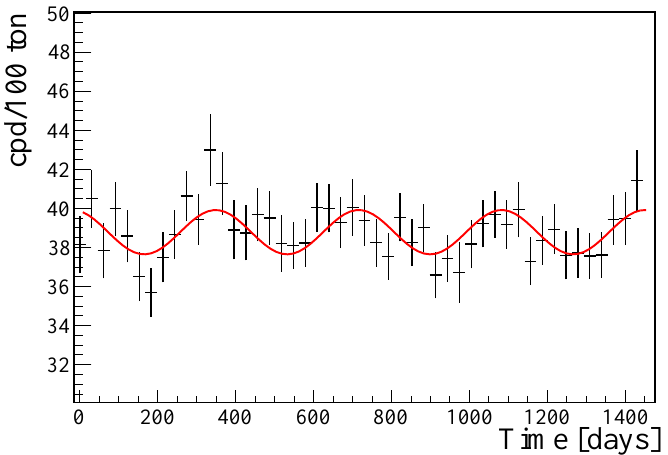
Figure 9. Borexino event rate in Phase II versus time in the 7 Be edge region, with associated modulation extraction in red. Distribution is plotted in time bins of